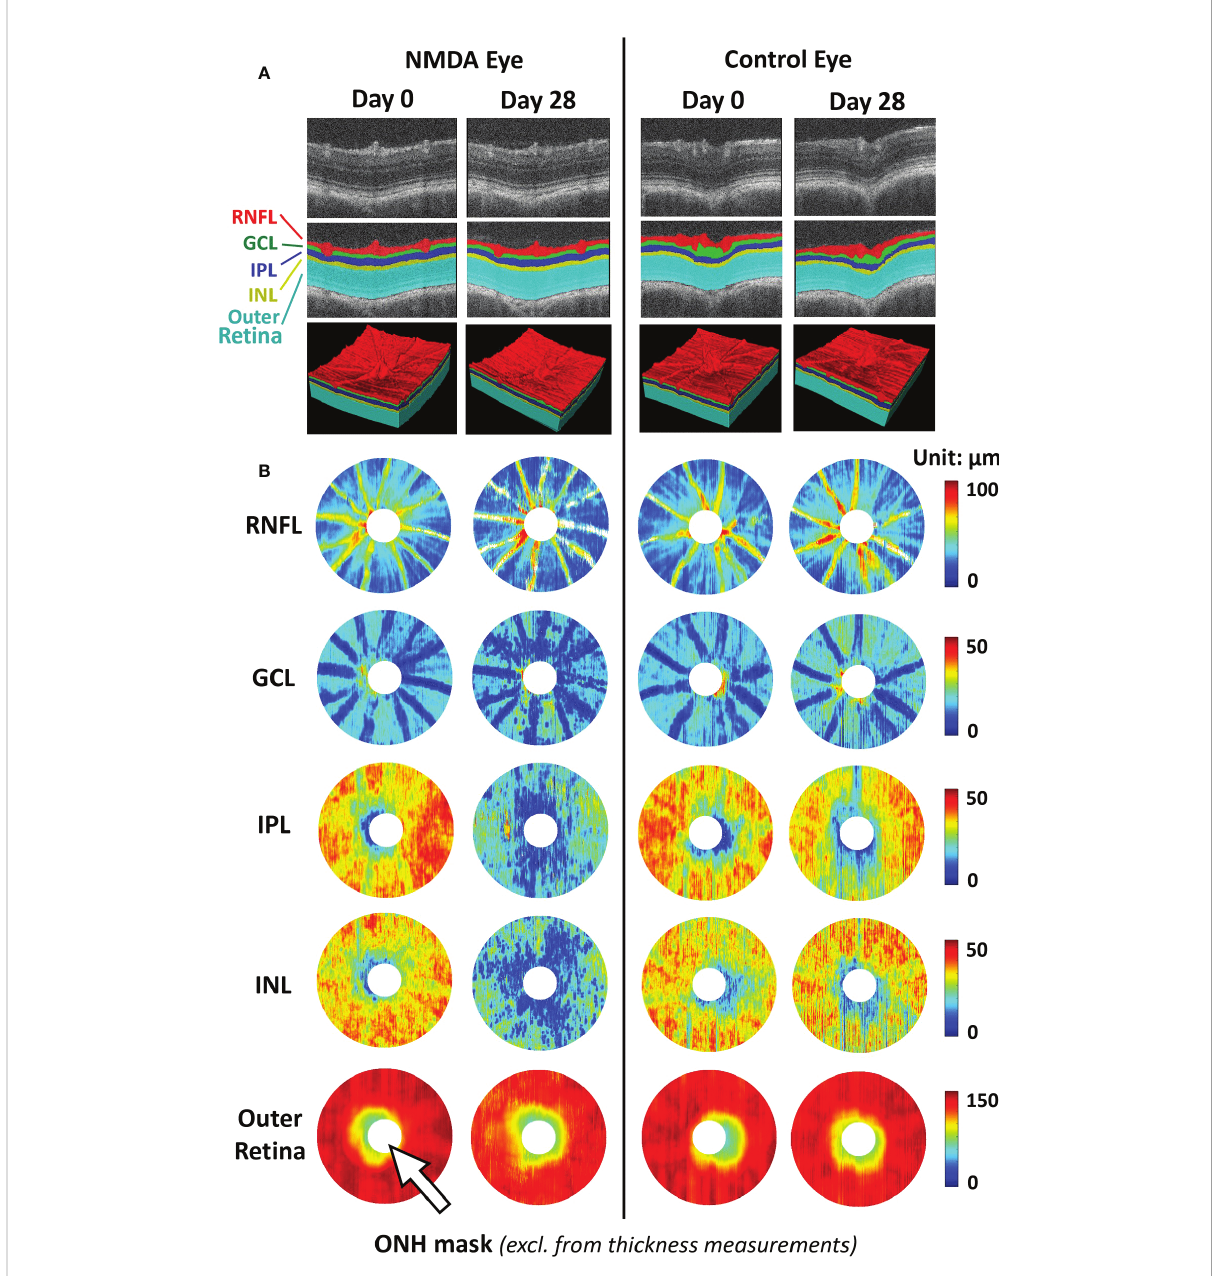
FIGURE 2 Representative images of deep learning-assisted automatic retinal layer segmentation (A) and the thickness measurements of 5 retinal layers for both injured and control rat eyes (B) before and 28 days after unilateral N-methyl-D-aspartate (NMDA) injection. Automatic retinal layer segmentation was achieved using LF-UNet - an anatomical-aware cascaded deep-learning-based retinal optical coherence tomography (OCT) segmentation framework that has been validated on human retinal OCT data (42). In this work, two techniques were applied to improve the ef fi ciency and generalizability of the LF-UNet segmentation framework when training with a small, labeled dataset – 1) composited transfer- learning and domain adaptation, and 2) pseudo-labeling. [excerpted from (42)]. (RNFL, retinal nerve fi ber layer; GCL, ganglion cell layer; IPL, inner plexiform layer; INL, inner nuclear layer; ONH, optic nerve